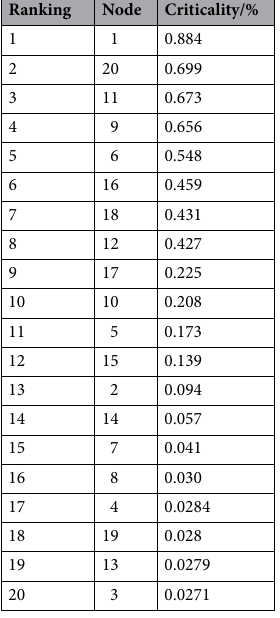
Table 4. Ranking of node importance in workshop network.